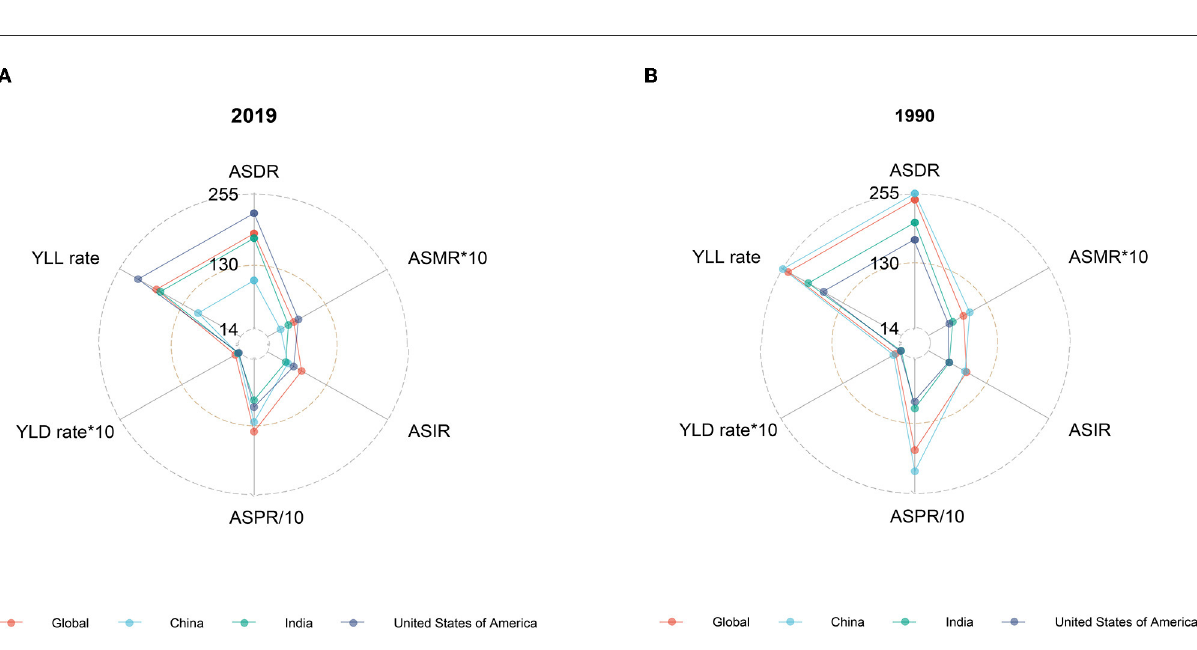
FIGURE2 Burden of HCV in ASRs, 2019 vs. 1990. (A) Epidemiological indicators of China, India, the United States, and the world in 2019. (B) Epidemiological indicators of China, India, the United States, and the world in